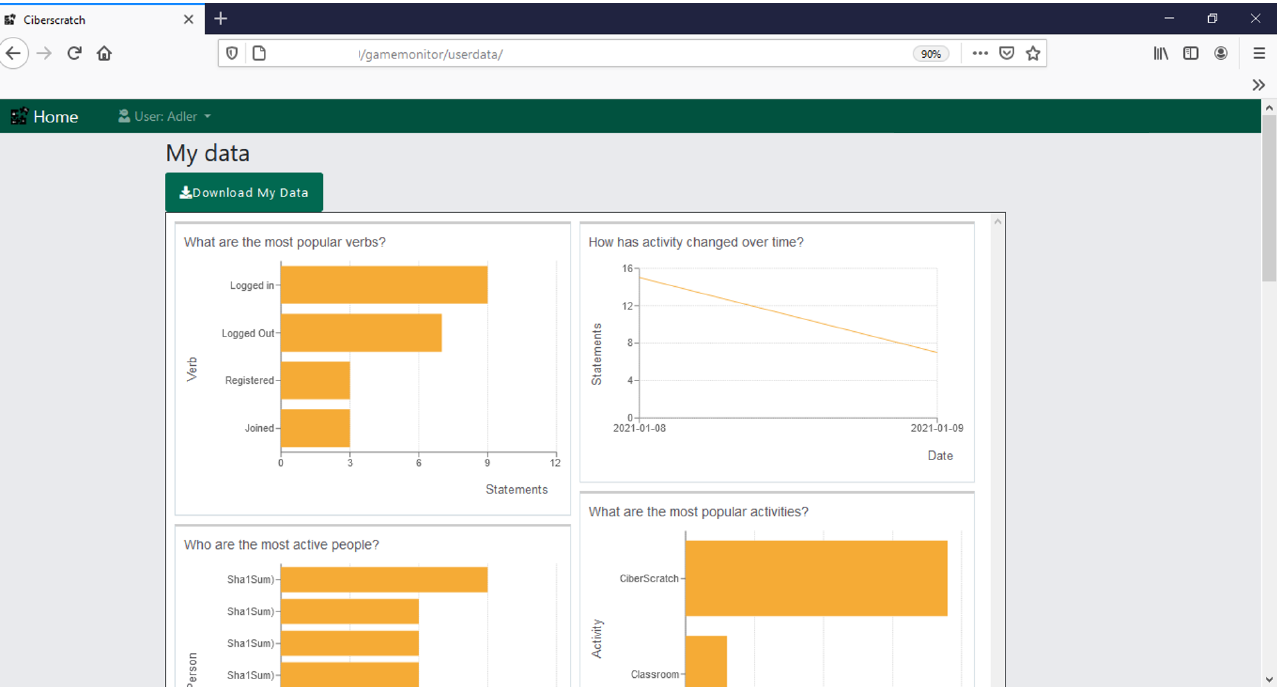
Figure 9. “My data” section in the CyberScratch